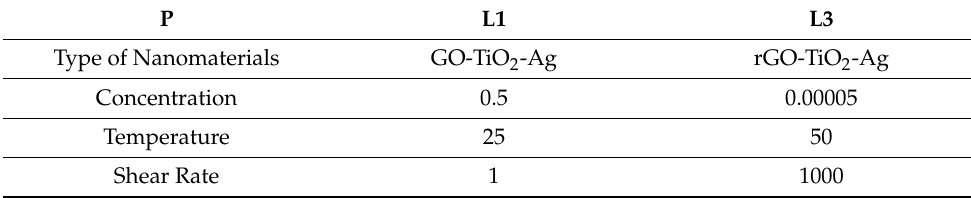
Table 1. Selected parameters and levels.